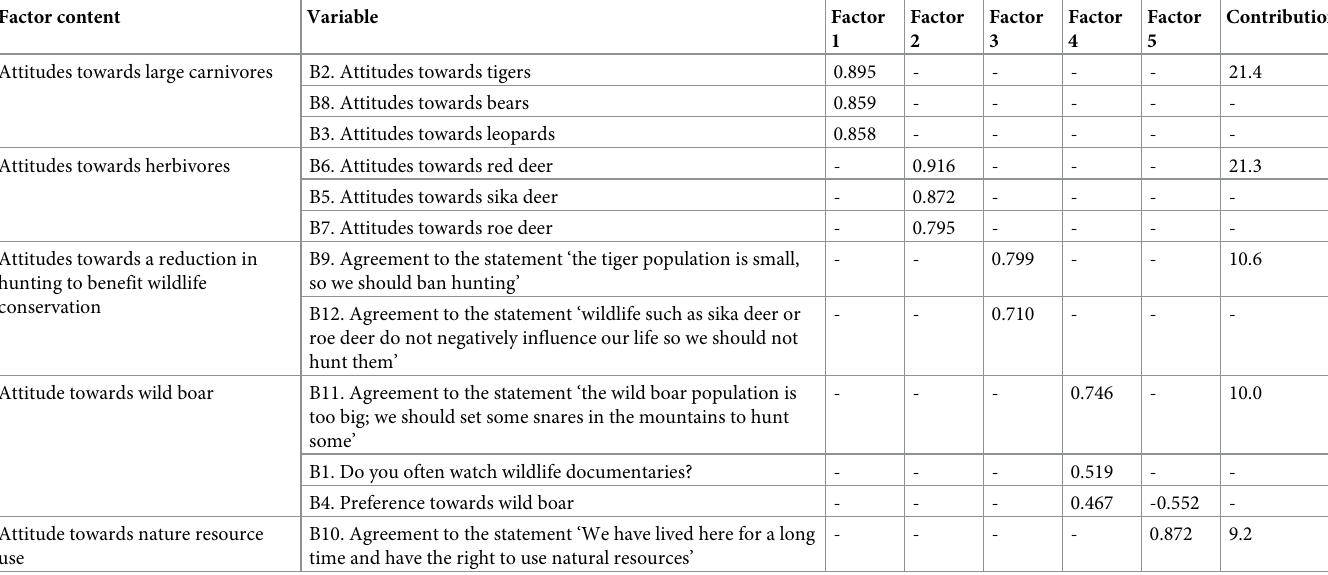
Table 2. Factor loading values based on exploratory factor analysis (N = 139). Total contribution of the factors is 72.5%, and all the loading coefficients are higher than 0.45, which means that there is a close correlation among each factor, and the common factors can be used to explain the variables effectively. By reading the loading values, 5 main attitude categories were classified as Factor 1, which could be described as the attitude towards carnivores; Factor 2 could be described as the preference towards herbivores; Factor 3 could be described as attitude towards reducing hunting to benefit wildlife conservation; Factor 4 could be described as the attitude towards wild boars; Factor 5 could be described as the attitude towards nature